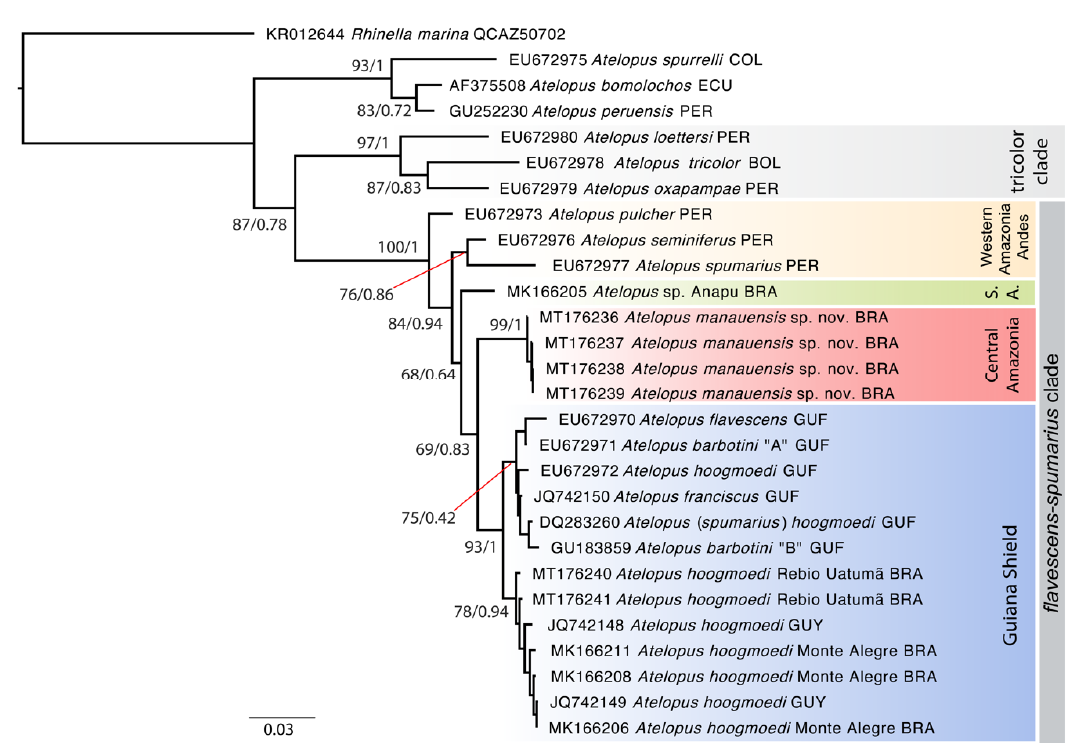
Figure 1. Phylogenetic reconstruction using Maximum Likelihood based on 614 base-pairs of 16S rRNA and 660 base-pairs of cytochrome c oxidase subunit I gene (COI). ode support is presented as bootstrap/posterior probability (PP). Horizontal yellow bar represents species distributed further west in Amazonia and on the eastern slope of the Andes; red bar represents the new species distributed around the city of Manaus (Brazil); blue bar denotes species distributed in the Guiana Shield. Abbreviations: (S.A.) south bank of the Amazon River ‒ green bar.